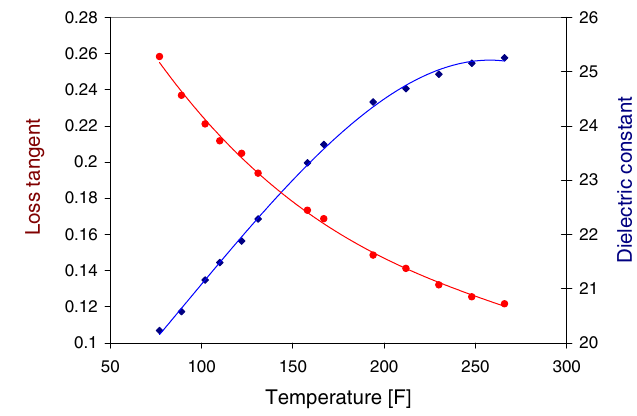
FIG. 9. (Color) Copper cavity with two antennas to measure the dielectric constant and loss tangent of a ceramic tile.